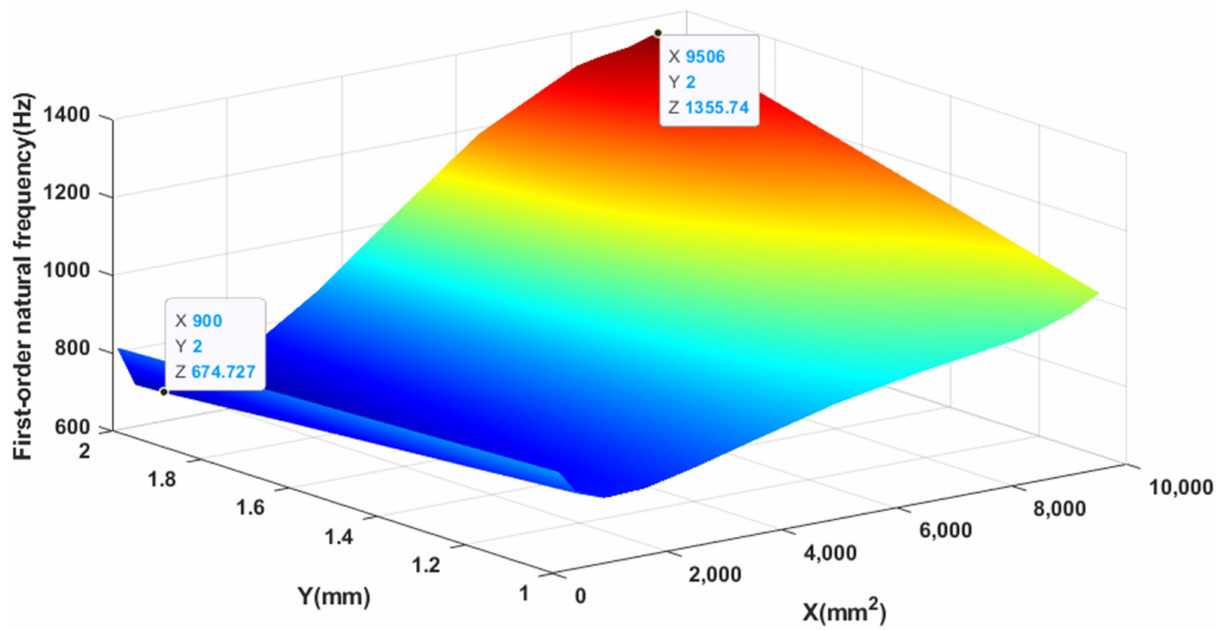
Figure 7. The variation of first-order natural frequency with area and